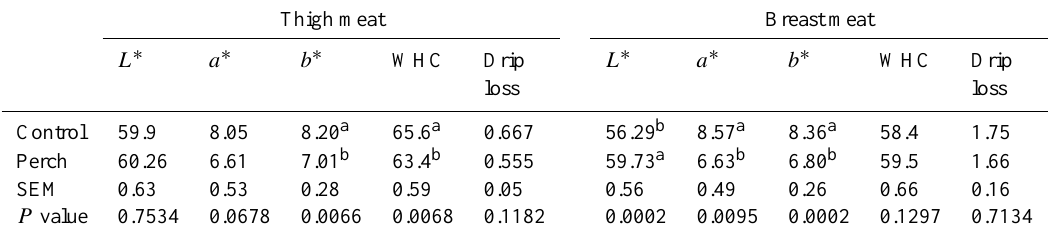
Table 4. Effects of perch availability on the L ∗ , a ∗ and b ∗ color values, drip loss, and water-holding capacity (WHC) of thigh and breast meat.